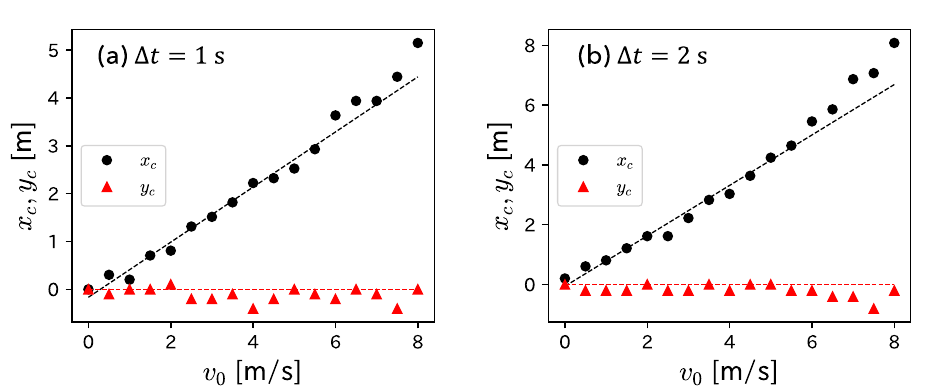
Figure 4. Heat maps of players’ arrival points for various initial speed v 0 = 1, 3, 5, 7 m/s, where ( a ) (cid:31) t = 1 s and ( b ) (cid:31) t = 2 s. The dotted line in each panel represents the arrival circle (4) with kinetic parameters estimated from the heat maps.